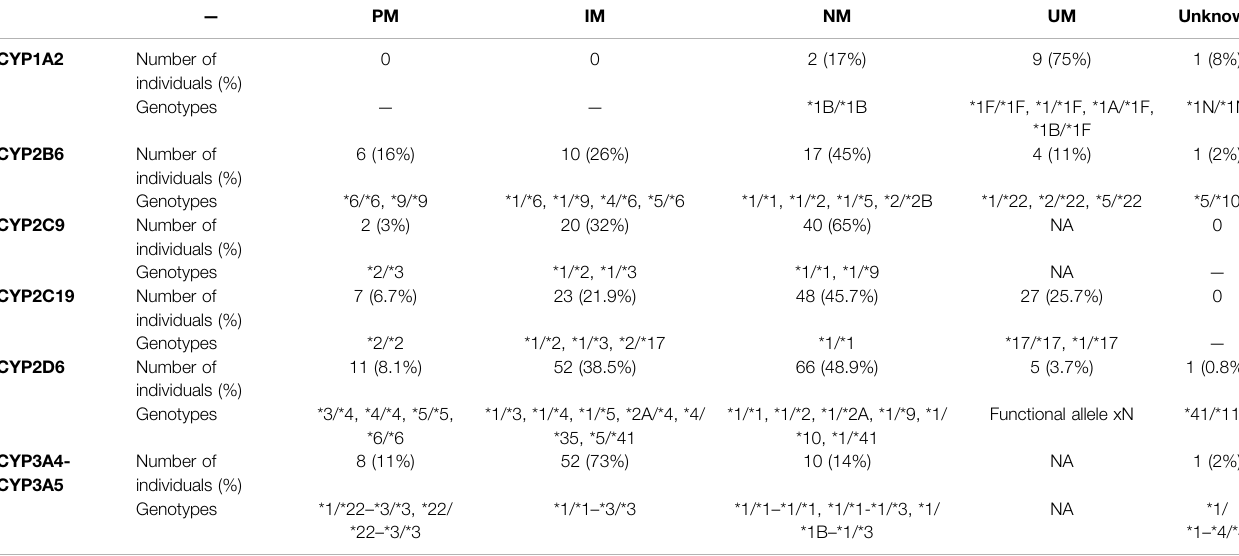
TABLE 2 | In patients with simultaneous genotyping and phenotyping, CYP predicted phenotype based on the identi fi ed